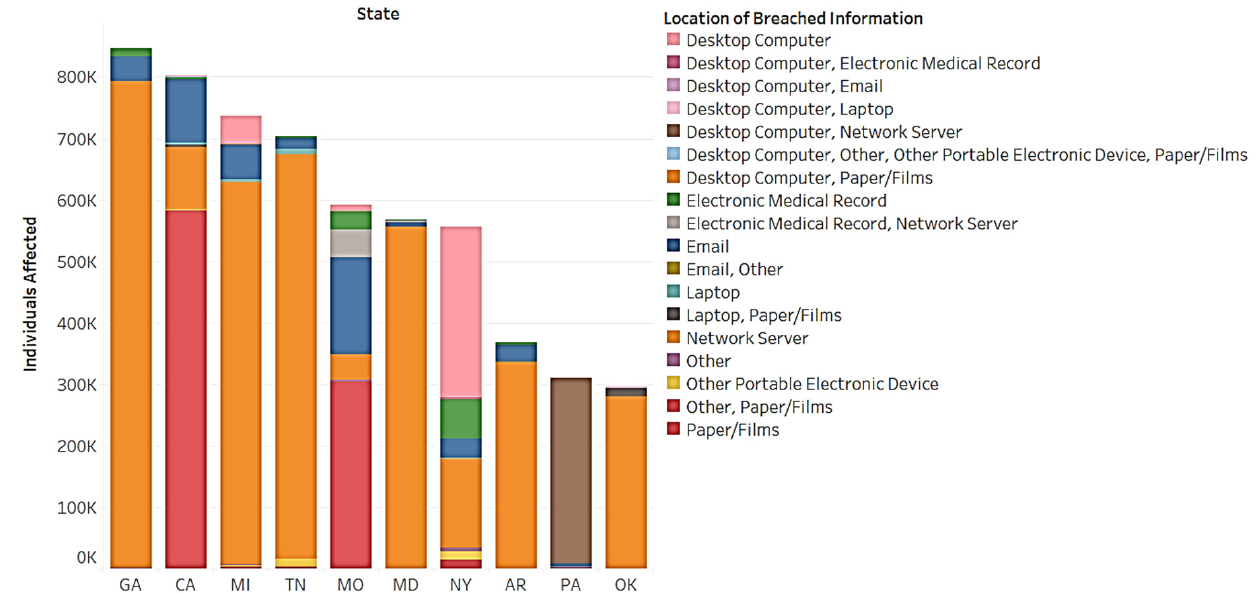
Figure 22. Geographical distribution of affected individuals by state and location of breached infor- mation.